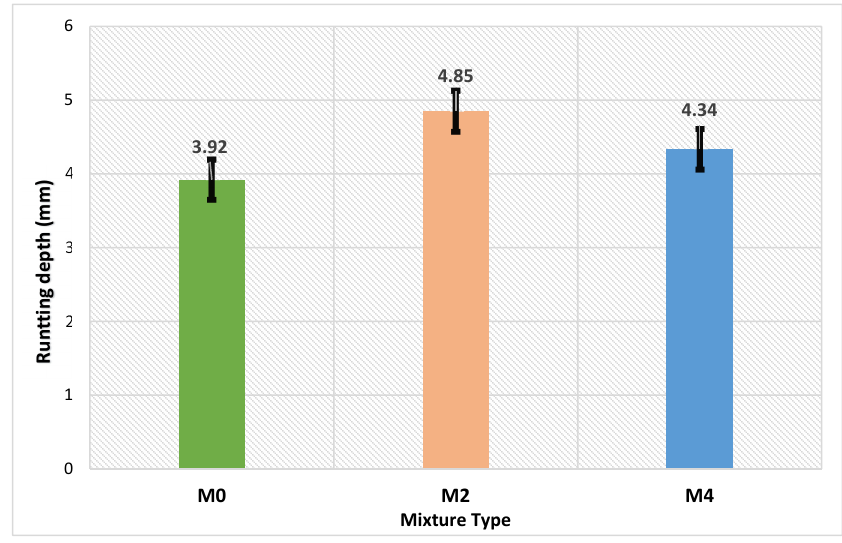
Figure 7. Rutting depth results.